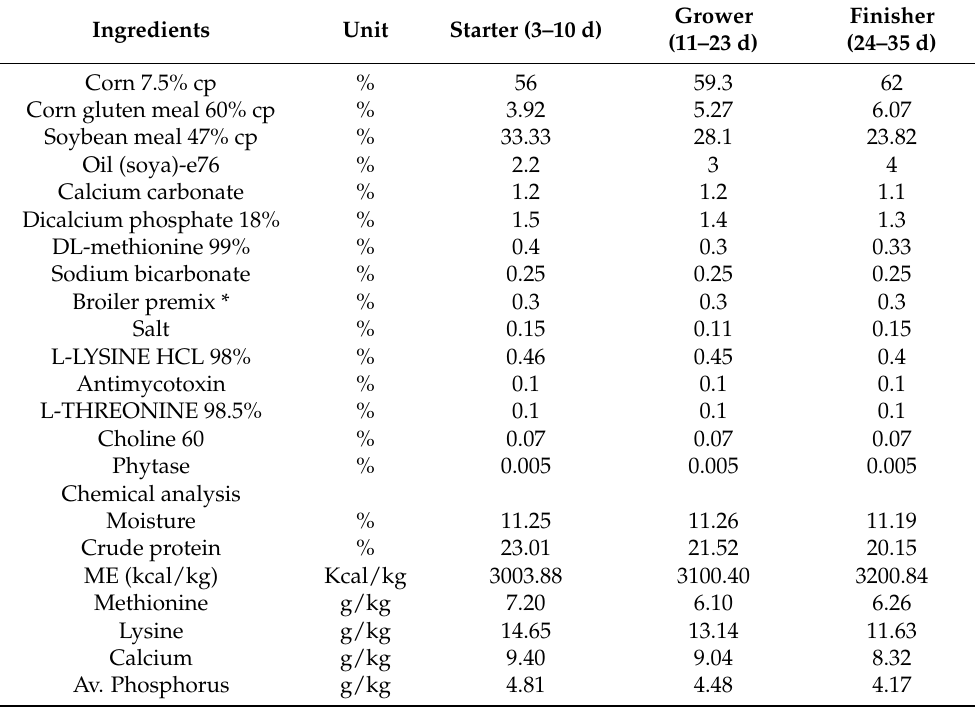
Table 1. The proximate chemical composition of the basal diet on a fed basis.